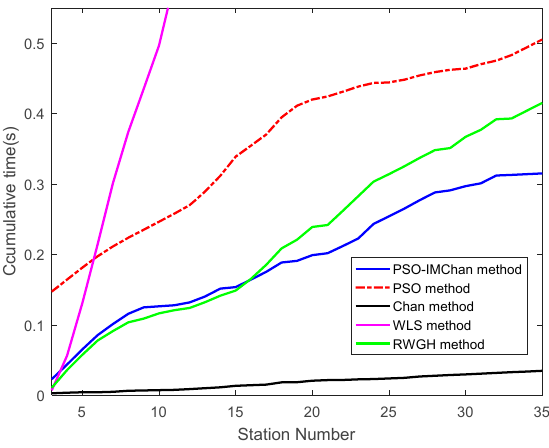
Figure 7. Required time for different methods versus the number of BS.